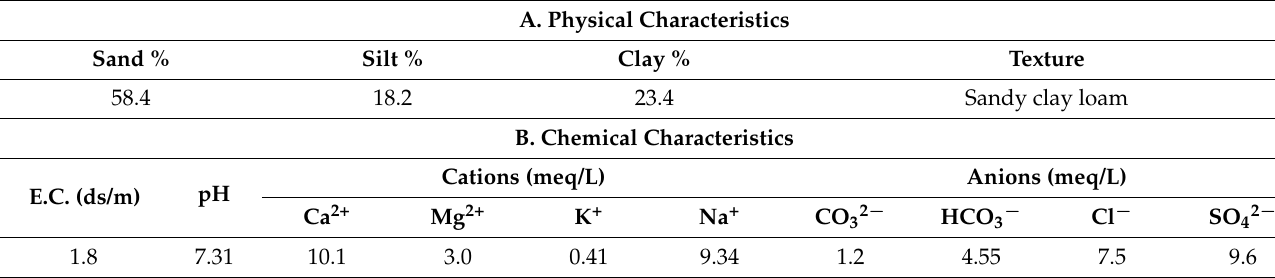
Table 1. Physical and chemical characteristics of the research